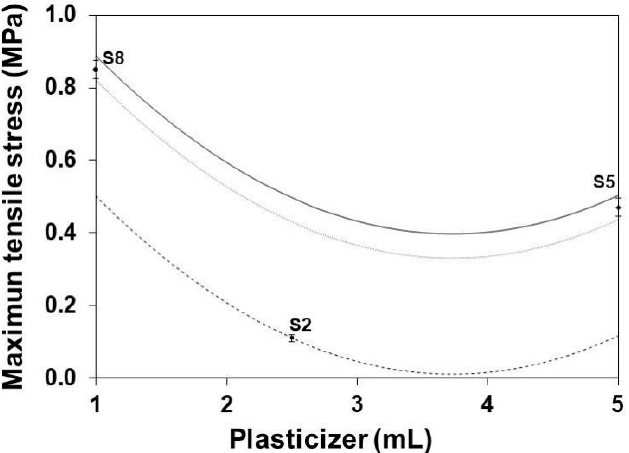
Figure 7. Effect of plasticizer on the MTS of SLGMs, varying the gelatin content: 1.0 g (continuous), 2.5 g (dashed) and 5.0 g (dotted). Experimental points (S2, S5 and S8). Conditions: water content = 50 mL; plasticizer content = 1.0 mL.